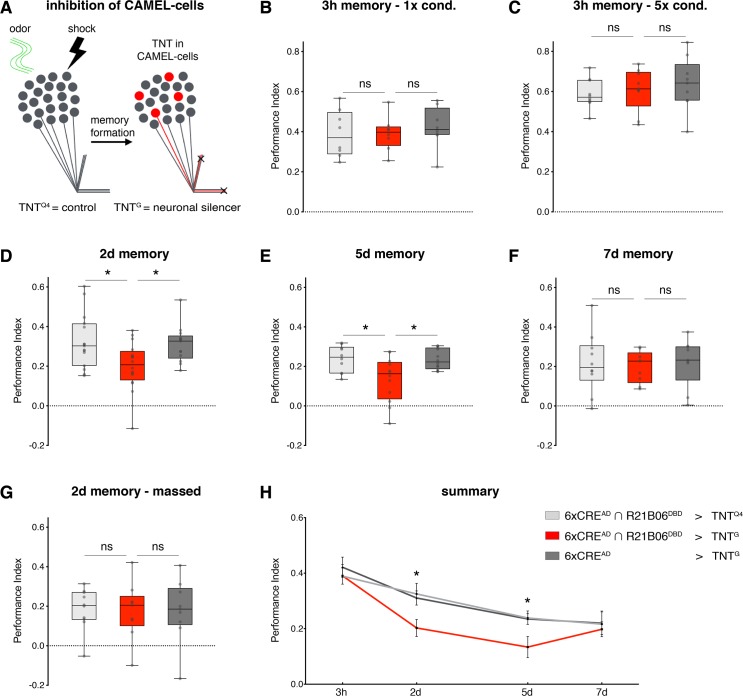
CAMEL neurons are required for LTM.(A) Schematic of the experimental design. CAMEL neurons are silenced by TNT expression to determine their requirement for memory expression. (B–C) Three-hour memory performances of control and experimental genotypes were indistinguishable after 1 (panel B) or 5 (panel C) rounds of spaced training. (D–E) Flies expressing active TNT in CAMEL neurons showed a significant reduction in aversive olfactory memory performance 2 days (panel D) and 5 days (panel E) after spaced training. (F) Seven days after spaced conditioning, the experimental genotype had no defect in memory performance. (G) The experimental genotype displayed normal ARM memory performance 2 days after massed training. (H) Summary of the data. For box blots: line, median; box, 75th–25th percentiles; whiskers, minimum to maximum (n ≥ 8). Data in panel H represent mean ± SEM. Asterisks indicate significant differences between relevant groups (*P < 0.05, ANOVA). ARM, anesthesia-resistant memory; CAMEL, CRE-activity–dependent memory engram label; CRE, cAMP response element; LTM, long-term memory; ns, not significant; SEM, standard error of the mean; TNT; tetanus toxin.